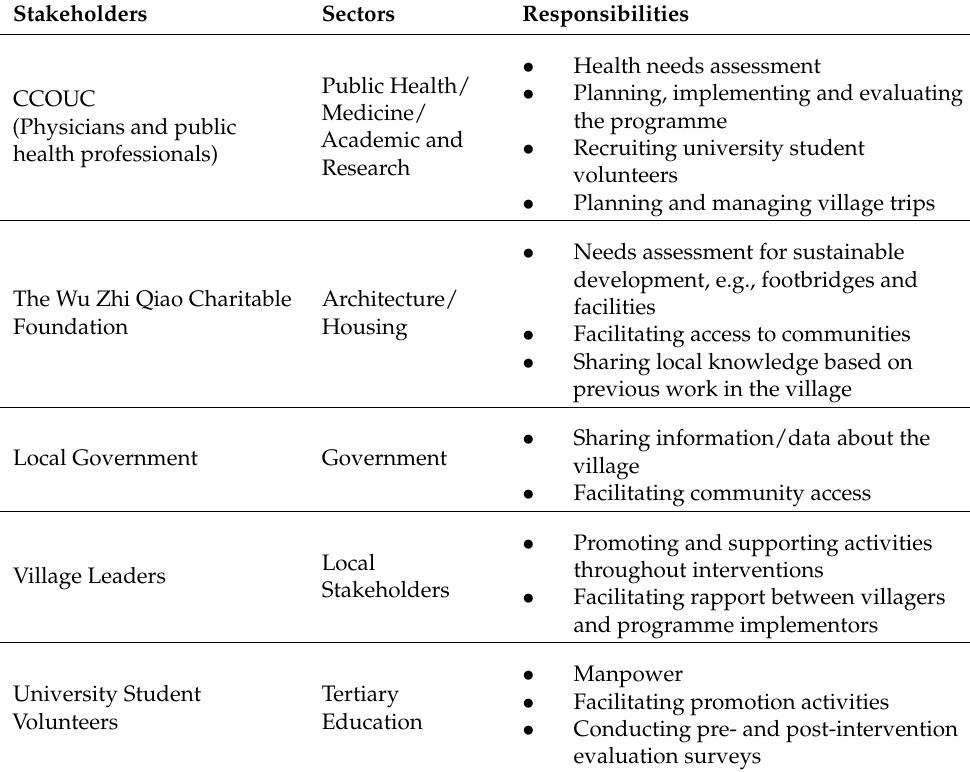
Table 1. Key Stakeholders and their